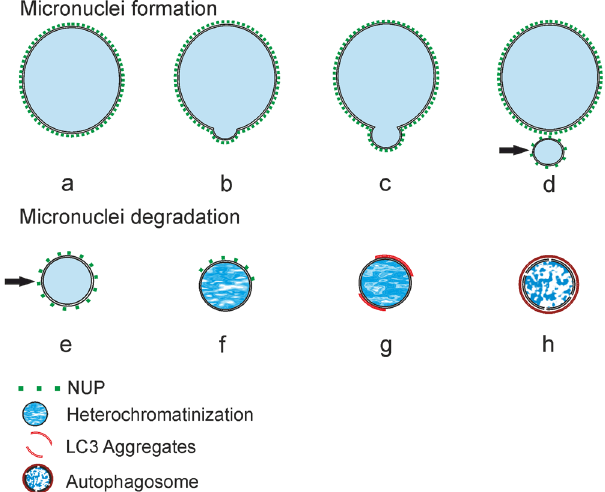
(green), ( b,c ) emerging chromatin extrusions (buds), ( d,e ) fully separated micronucleus with lower expression of NPC proteins, ( f ) heterochromatinized micronucleus possessing partial NPC signal, ( g )